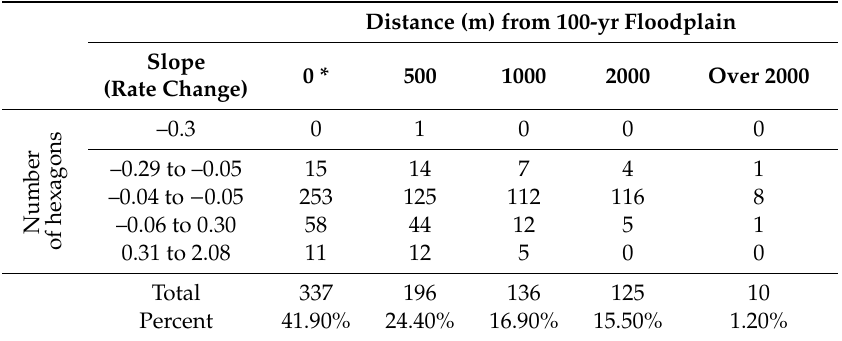
Figure 11. Number of residential building permits (from 2006 through 2017) (A) and rate of new residential construction (slope of the regression line) for each hexagon (B). Increasing rates of permits through time have a positive slope (shown in orange and red). Table 7. Rate of change in building permits (2009 to 2017) and distance to floodplain.